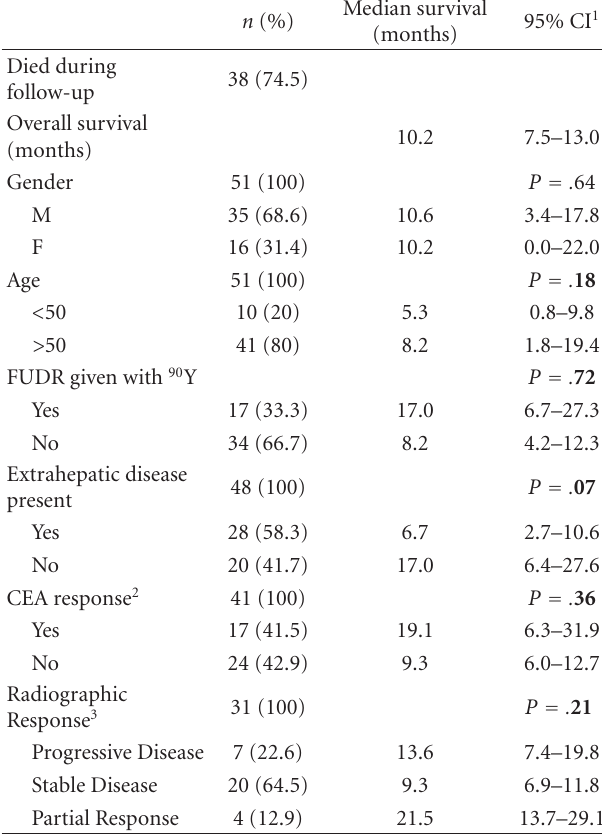
Table 3: Clinical endpoints: survival, biochemical, and radiologic response. Survival analyses to compare whether survival advantage was associated with studied variables was performed using log-rank